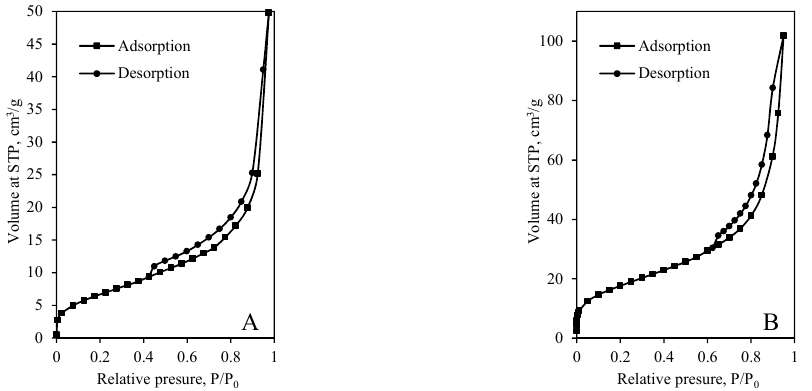
Figure 6. N 2 adsorption–desorption isotherms of products (CaO/SiO 2 = 1.0 at 200 °C) after 12-h synthesis from mixtures: lime–GSW ( A ), lime–calcined opoka ( B ).